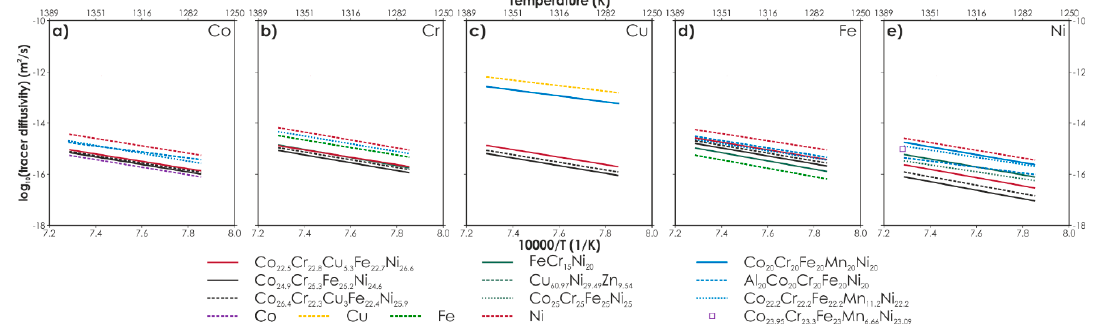
Figure 14. Comparisons of Arrhenius plots of the obtained tracer diffusivities in the Co-Cr-Cu-Fe-Ni system, with the reported temperature-dependent data on diffusion in various FCC systems (after [37]). Reprinted from Journal of Materials Science & Technology 34 (2018), Experimental and numerical studies on the sluggish diffusion in face-centered cubic Co-Cr-Cu-Fe-Ni high-entropy alloys, 434–444, Copyright 2018, with permission from Elsevier.